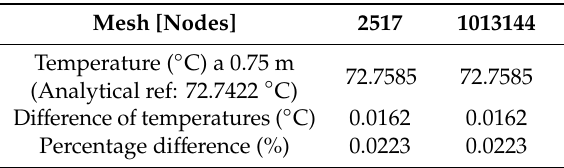
Table 1. Temperatures for the validation of FEMM.